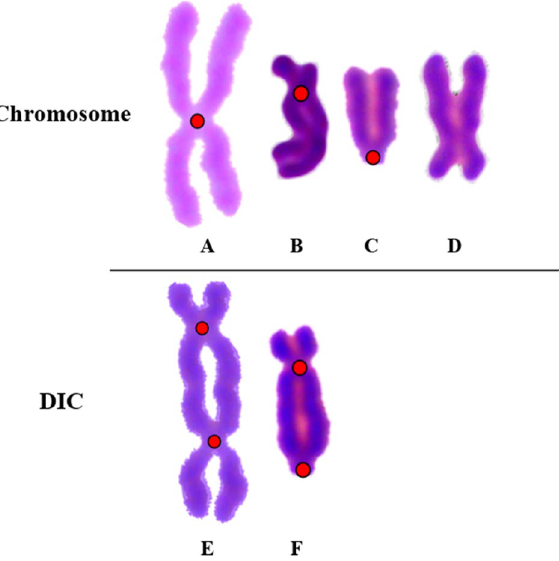
Figure 12. Typical chromosomes and DICs. ( A ) common chromosome, ( B ) chromosome with long arms entangled together, ( C ) chromosome with the centromere at the ends, ( D ) weakly split chromosome, ( E ) common DIC, ( F ) DIC with the centromere at the